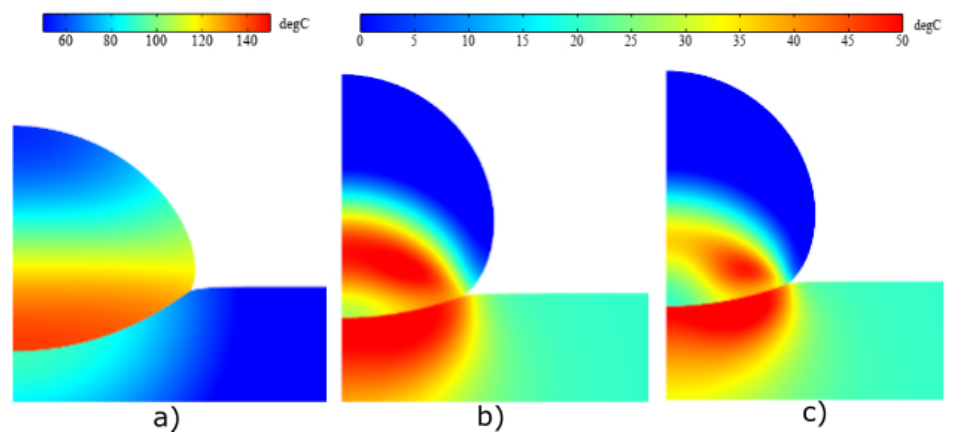
Figure 9. Temperature at the time instance of the maximum indentation for particle sizes ( a ) 1 μ m, ( b ) 30 μ m, and ( c ) 100 μ m.